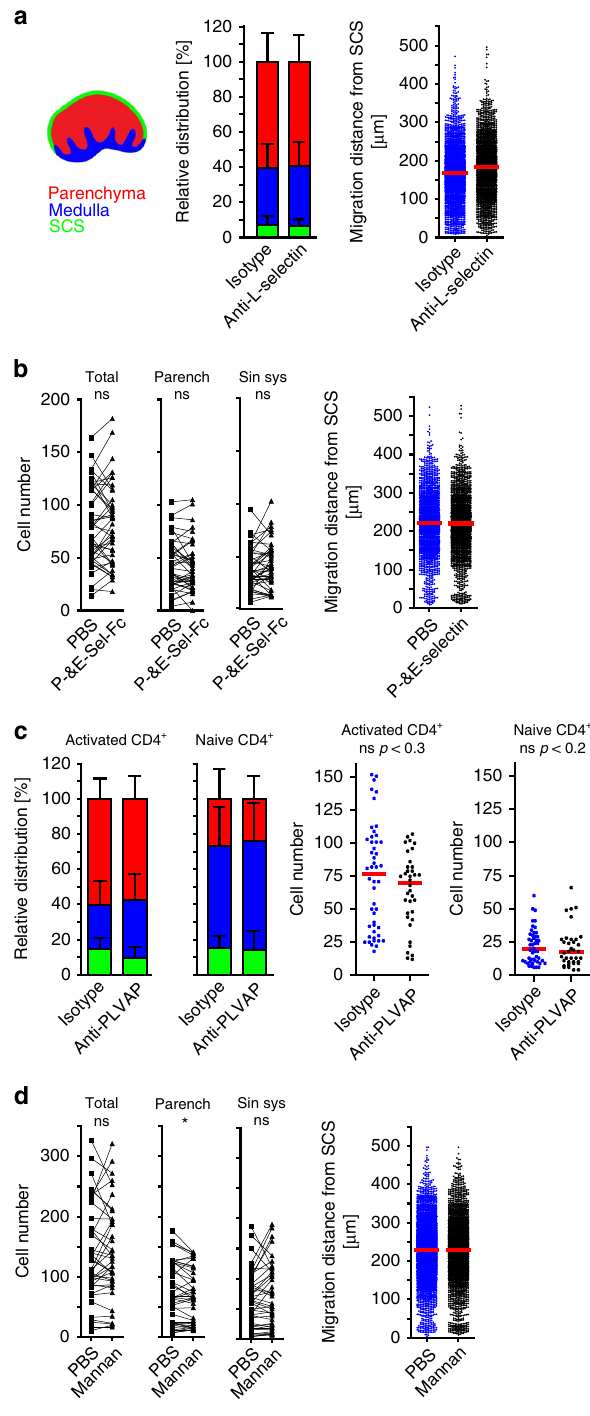
Fig. 5 Selectins, PLVAP, and mannan-binding proteins do not contribute to homing of lymph-derived activated CD4 T cells. Quantitative analysis of adoptively transferred cells in popliteal LNs 90 min after i.l. injection of a , b , d 1:1 mixtures of activated CD4 + T cell combinations as indicated; c activated CD4 + T cells into different recipients; a relative distribution as schematically depicted and migration distance of activated T cells treated with isotype or anti-L-selectin mAb; b absolute distribution and migration distance of activated T cells treated with isotype or anti-P- and E-selectin Ig fusion protein (parench parenchyma, sin. sys sinus system); c relative distribution and absolute cell counts of activated T cells injected into recipients treated with isotype or anti-PLVAP mAb; d absolute distribution and migration distance of activated T cells treated with PBS or Mannan. Data are